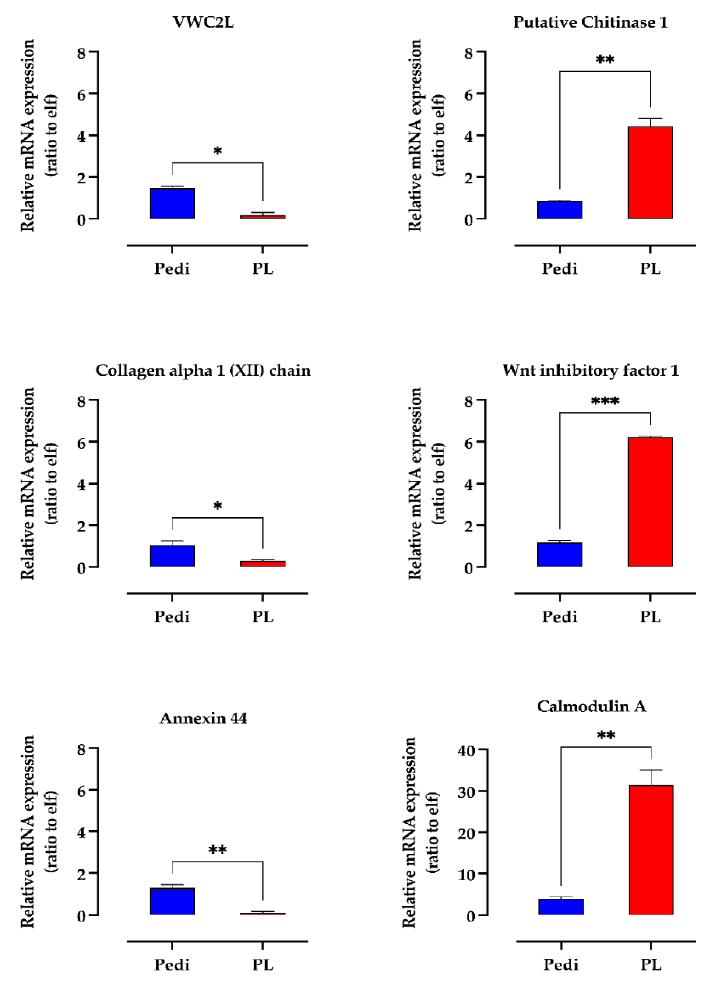
Figure 3. Relative expression levels of selected genes before (pediveliger, Pedi) and after (postlarvae, PL) settlement induction by a conspecific cue from shells in C. gigas using quantitative real-time PCR. Data are expressed as the mean + SD (n = 3). Values with “*, **, ***” are significantly different ( p < 0.05, <0.01, <0.001, respectively). Abbreviation: VWC2L = von Willebrand factor C domain-con- taining protein 2-like.